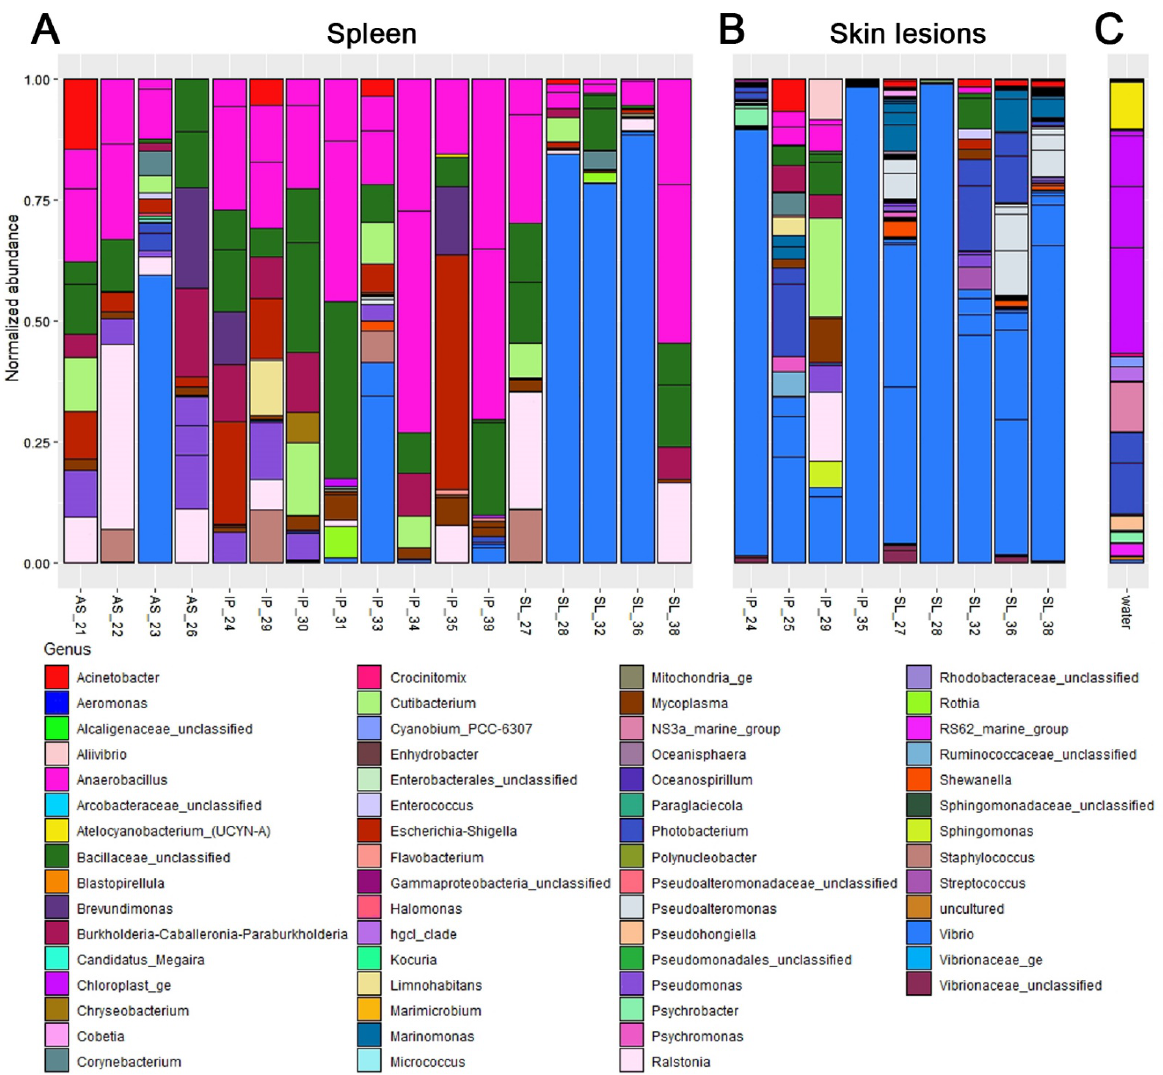
Figure 3. Composition of bacterial communities in rainbow trout and water collected in the fish farm during a vibriosis outbreak (AS—asymptomatic, IP—with infectious process, SL—with severe lesions). ( A )—composition of the spleen OTUs. ( B )—OTU composition of skin lesions (if the fish had any). ( C )—composition of OTUs of water on the farm. OTUs are colored by